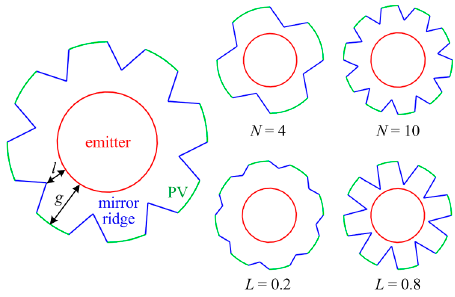
Figure 6. Schematics and the changed variables of configuration 2.